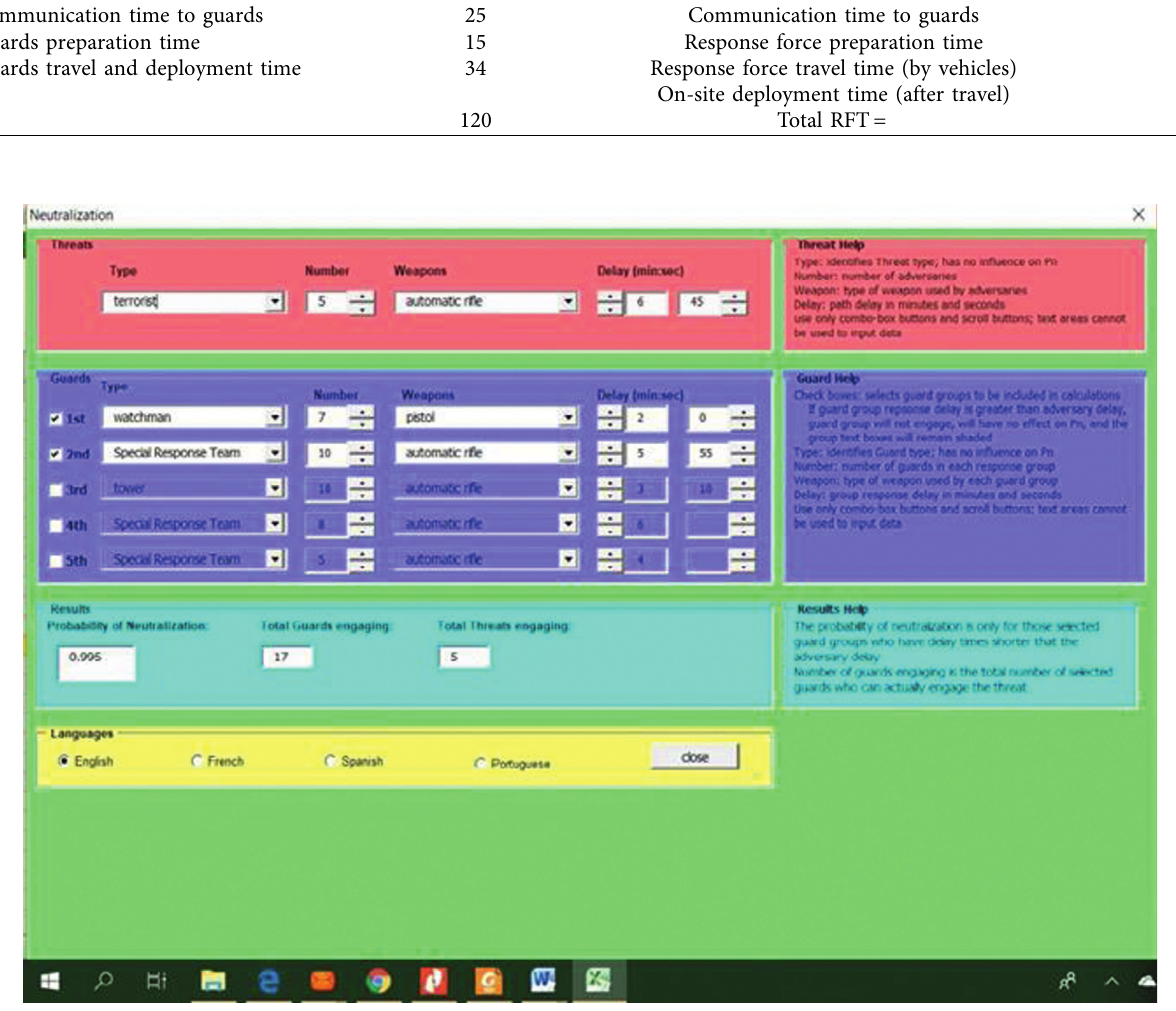
N based on Table 1, response force delay times, and their